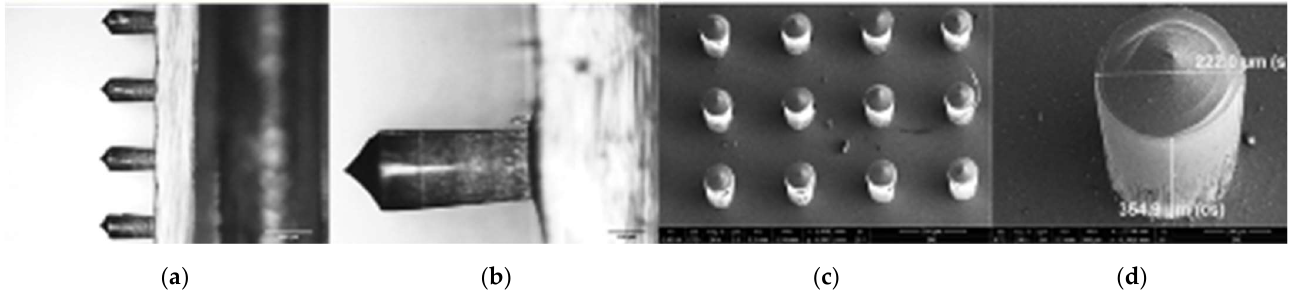
Figure 2. The in-house produced MNs visualized by optical microscopy ( a , b , lateral view) and SEM ( c , d , top view). Ruler in ( a , c ) is 500 µm, and in ( b , d ) is 100 µm. The polymeric MNs fabricated with PVA 4-88 with 0.1% v / v of glycerol (from herein designated as PVA G ) were also observed by optical and SEM microscopy (Figure 3).